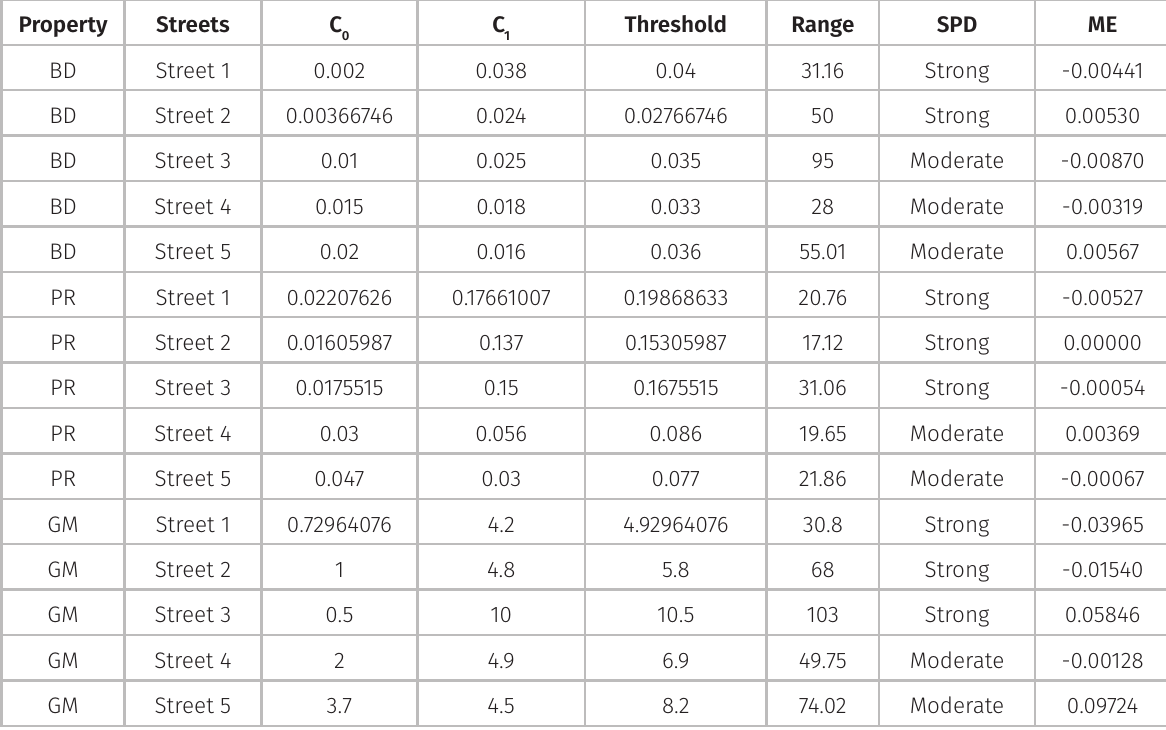
Table II. Parameters of semivariograms, spatial dependence degree (SPD) and mean error (ME).